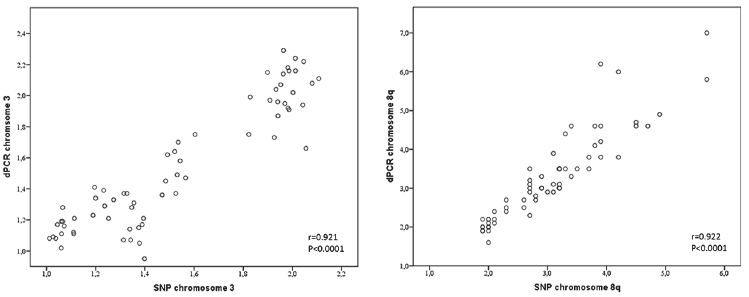
Fig 3. Correlation between dPCR and SNP with regard to chromosome 3 and 8q copy numbers. Copy numbers of chromosome 3 and 8q in UM calculated with SNP and dPCR display a strong correlation (r = 0.921 and r = 0.922, p < 0.0001), indicating that these methods cross validate each other.